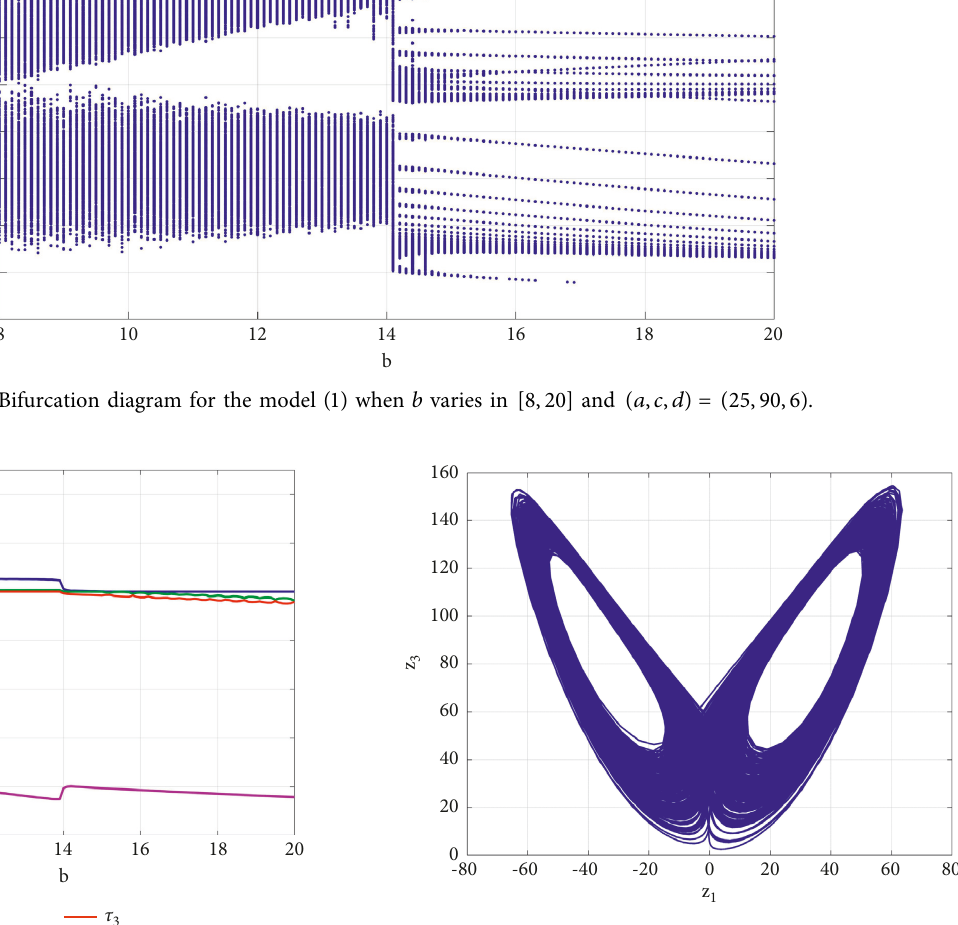
Figure 11: A hyperchaotic attractor of the model (1) for b � 13 . 8 and ( a, c, d ) � ( 25 , 90 , 6 ) .